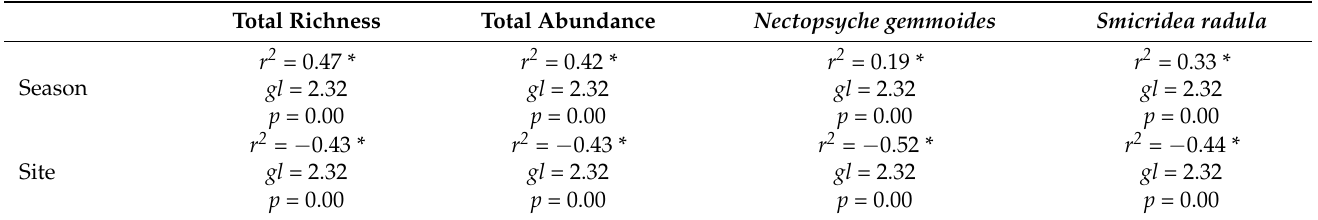
Table 9. Multiple correlation coefficients between season, site, total richness, total abundance of Trichoptera, and the two dominant species, in the Sierra de Ju á rez, Oaxaca, Mexico. gl = degrees free, * significative